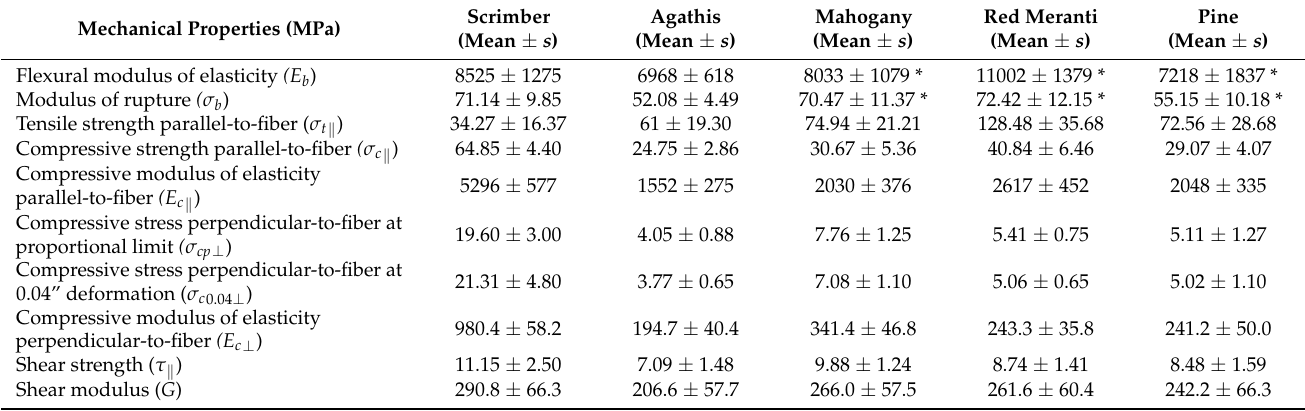
Table 3. Mechanical property test results for bamboo scrimber and timber specimens.